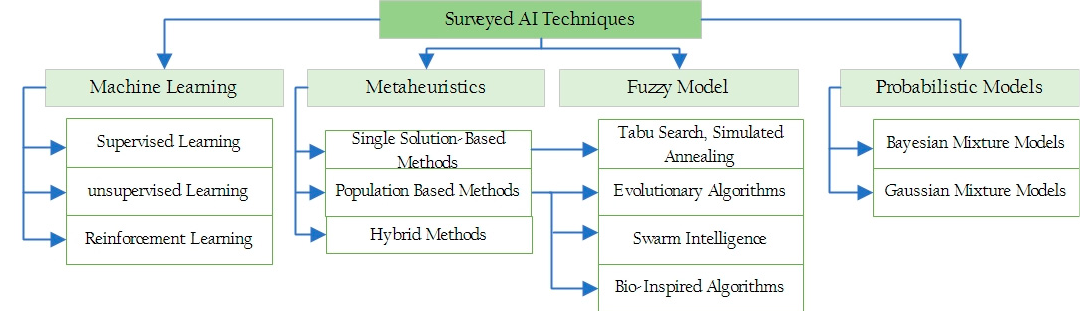
Figure 3. Sharp rise in the use of AI techniques for cognitive sensing solutions in recent years .